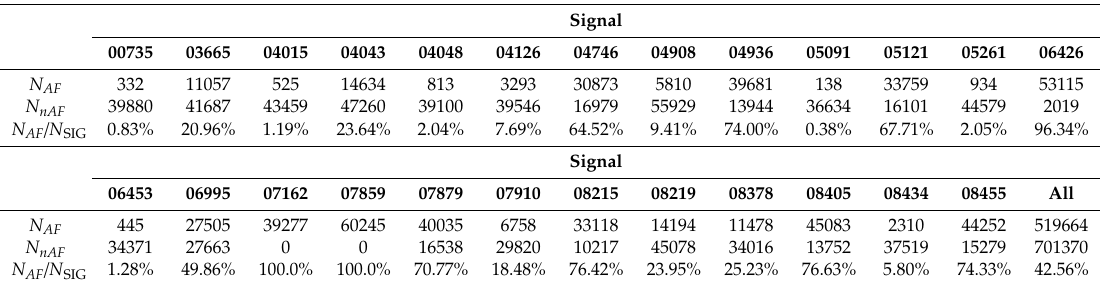
Table 1. The size of the analyzed classes described by the number of AF ( N AF ), non-AF ( N nAF ) episodes, as well as by the percentage of AF episodes ( N AF ) to the total number of the heartbeats ( N SIG ) in a given